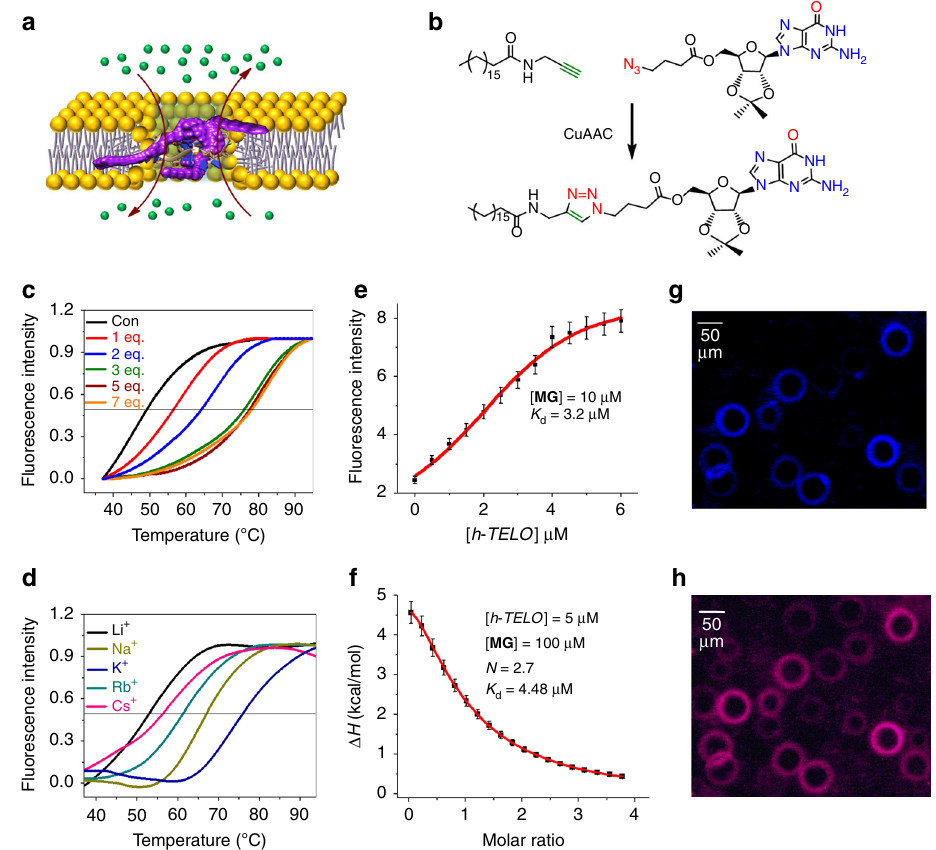
Fig. 1 Interaction of MG with h-TELO . a Scheme showing K + transport by the h-TELO ionophore within a lipid membrane. The h-TELO G-quadruplex is anchored to the lipid membrane by guanosine derivatives ( MG ) containing lipophilic chains (purple). The K + -ions are depicted as green balls and Cl − -ions are shown as orange balls. b Scheme outlining the synthesis of monoguanosine derivative ( MG ). c Melting pro fi le of h-TELO stabilized by increasing concentration (0 – 7 equiv.) of MG in 10 mM HEPES, 100 mM KCl buffer, pH 7.4 (T m of h-TELO is 49 °C in the same buffer). d Melting pro fi le of 3:1 MG/ h- TELO in the presence of different metal ion containing buffer (10 mM HEPES, pH 7.4, containing 100 mM LiCl, NaCl, KCl, RbCl, and CsCl, respectively). e Fluorescence intensity pro fi le of MG upon titration with increasing concentration of h-TELO in 10 mM HEPES, 100 mM KCl buffer, pH 7.4. f ITC titration of MG with h-TELO in 10 mM HEPES, 100 mM KCl buffer, pH 7.4. Fluorescent images ( λ em = 355 nm) of lipid vesicles (GUV) g with MG/ h-TELO and h co- staining with MG/ h-TELO and membrane-binding dye, Nile red. Source data are provided as a Source Data fi le. Data are means ± SD ( n =